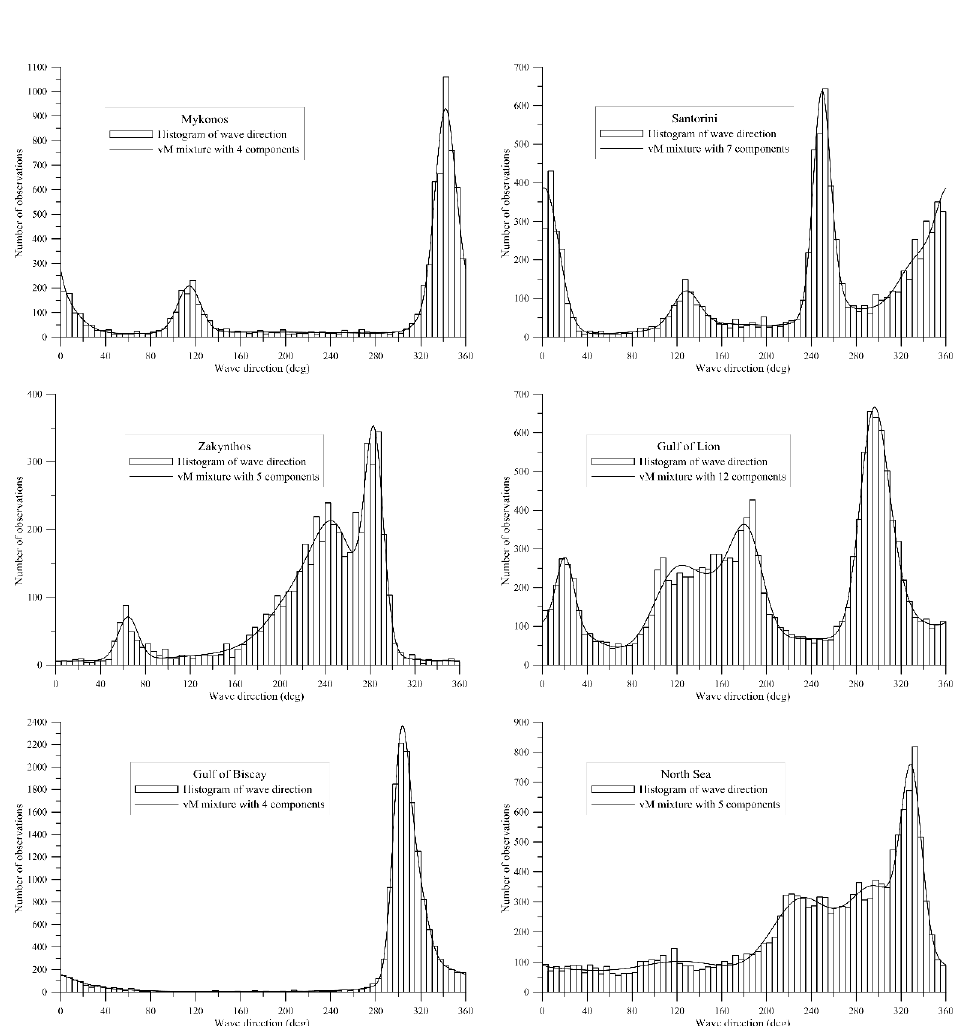
Figure 4. Histograms of wave direction along with the fitted vM mixture distributions for the examined locations.